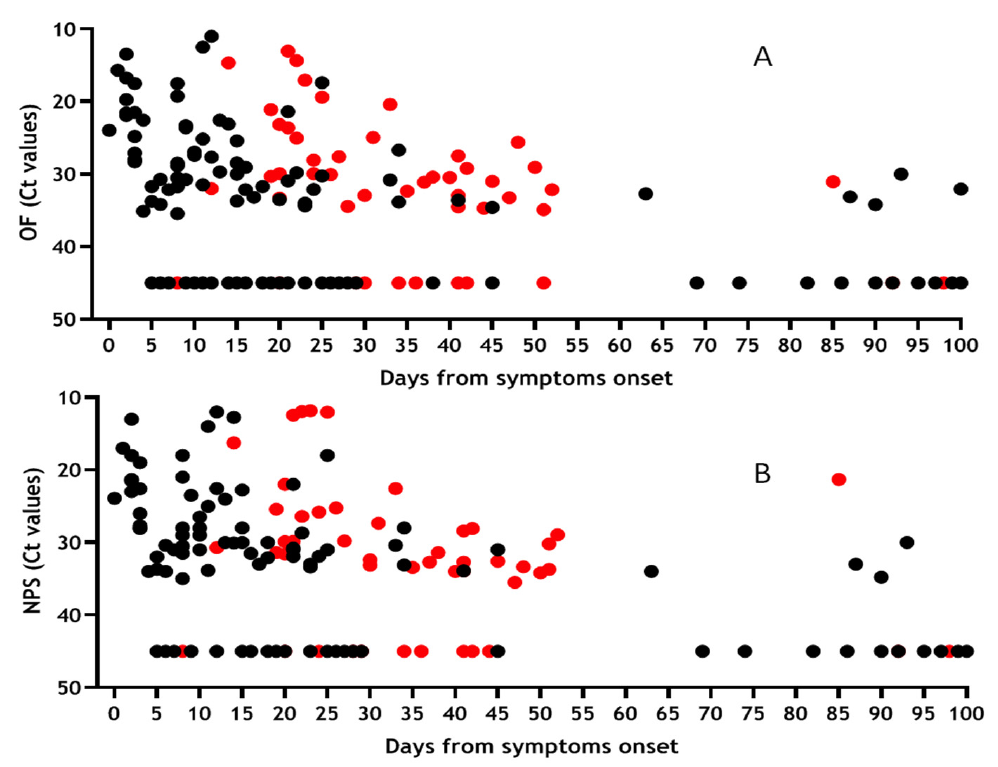
Figure 3. Shedding of SARS-CoV-2 RNA in OF and NPS samples based on days from symptom onset. Results obtained from 162 samples tested for the presence of SARS-CoV-2 RNA both in OF ( A ) and NPS ( B ) and expressed as Ct values vs. days from symptoms onset. Red symbols refer to samples coming from patients with severe COVID-19 disease, while black symbols refer to paucisymptomatic + asymptomatic patients.